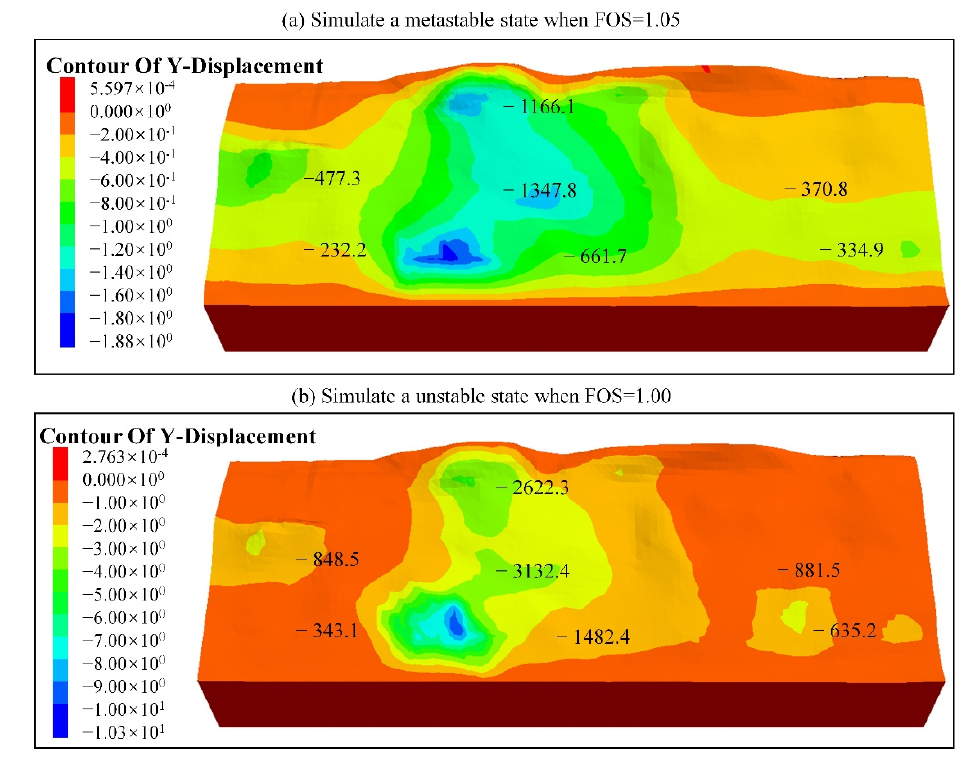
Figure 11. Displacement simulation results for a given evolutionary condition. Table 5. Two sets of displacement warning thresholds (unit/mm).